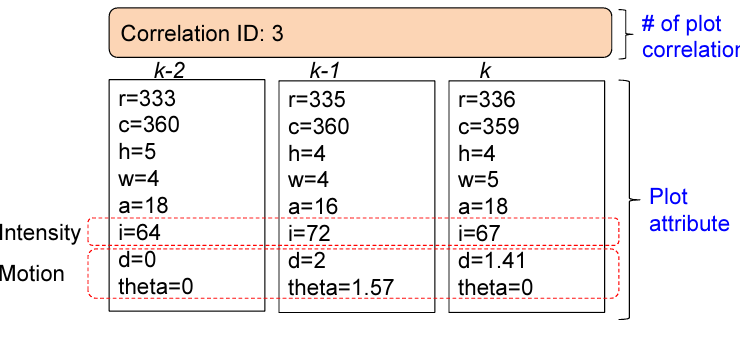
Figure 19. Attributes of the three-plot correlation and temporal behavior data of intensity and motion used for a statistics-based clutter rejection.